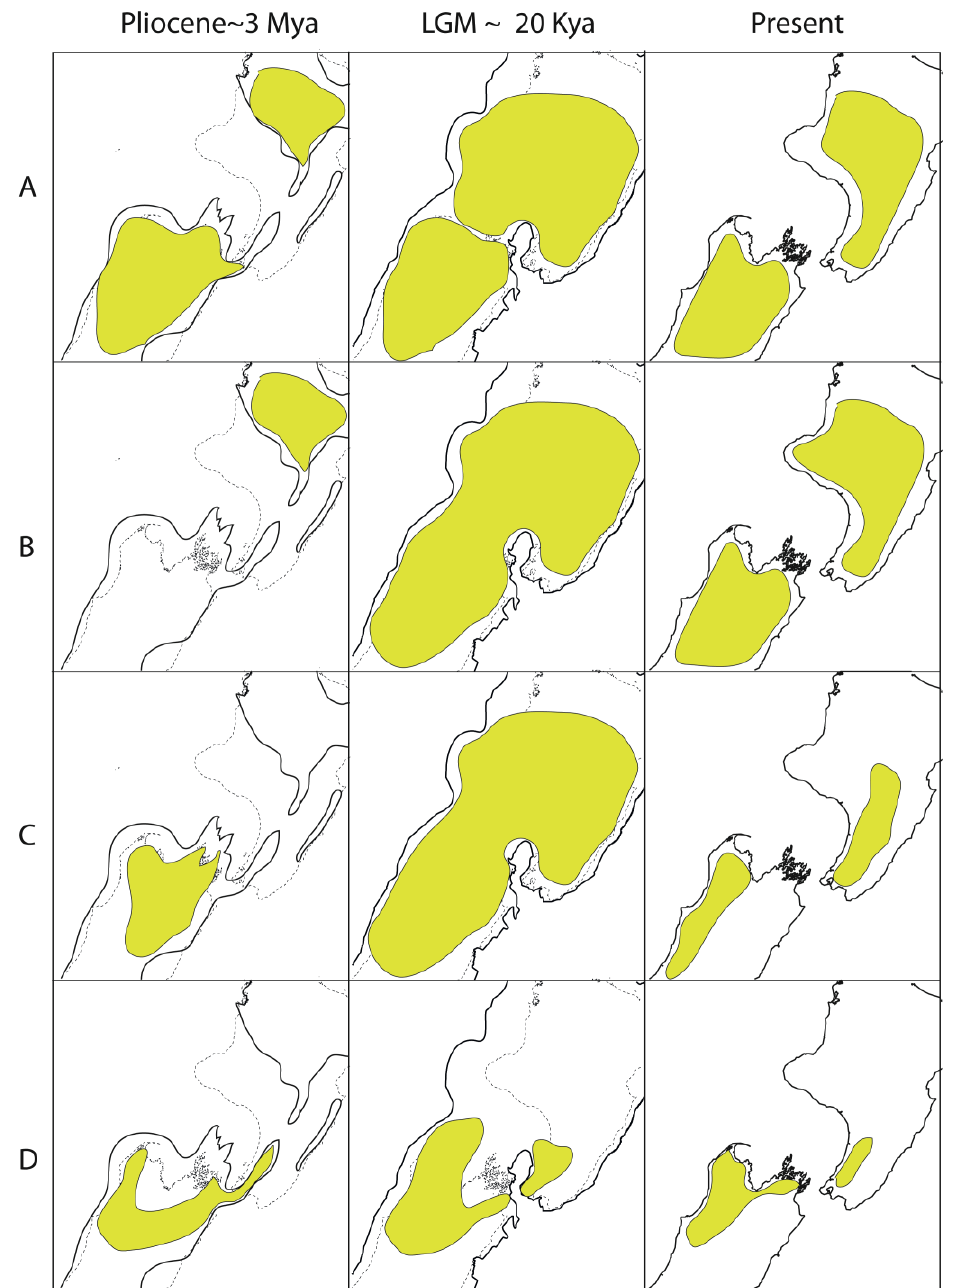
Figure 5. Cook Strait connections. A wide range of scenarios for South Island-North Island phylogeography are plausible. Yellow area indicates range of hypothetical taxon. ( A ) Population might be allopatric on older islands having moved between by oversea dispersal, before coming parapatric during LGM and so remaining specific to different islands; ( B ) Taxon might exist on one island only, expanding its range during LGM and then being partitioned as sea-level rises; ( C ) Taxon might initially be restricted to alpine environment on one island and colonizing new alpine environment when able during extension of lowered alpine habitat in LGM; ( D ) Taxon range in former South Island might result in occupation of southern North Island as it forms before